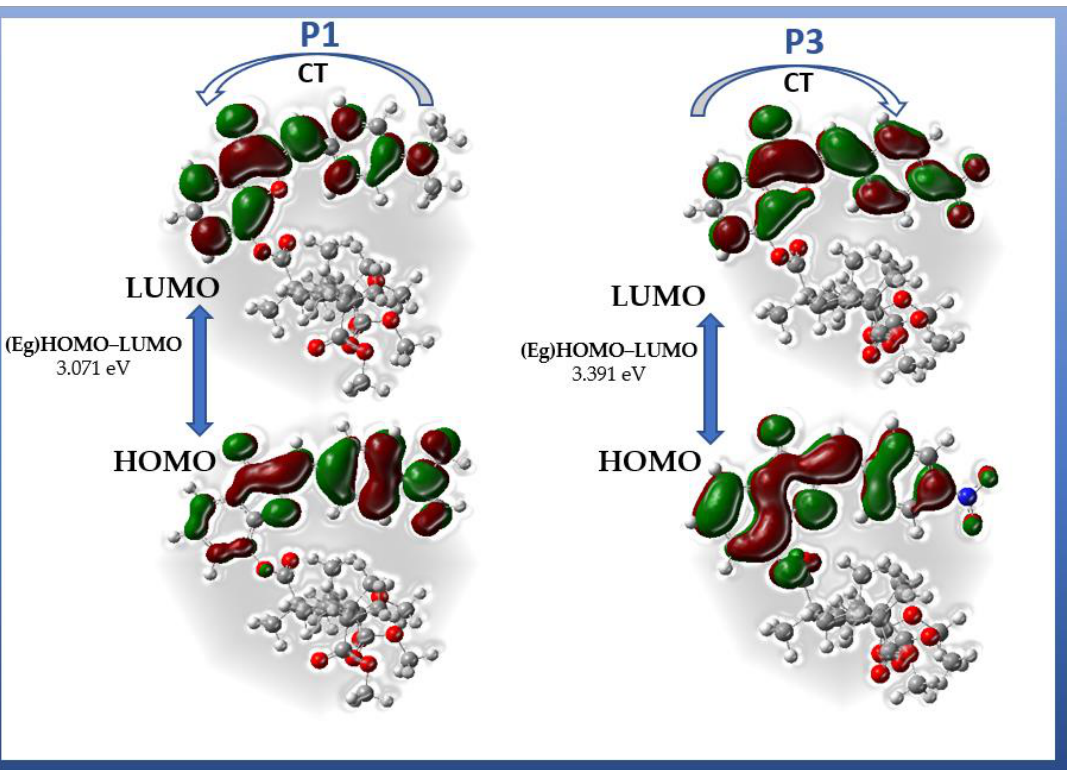
Figure 6. Frontier molecular orbitals HOMO and LUMO of compounds P1 and P3 and the intramolecular charge transfer (ICT) process between donor and acceptor groups of compounds P1 and P3 .